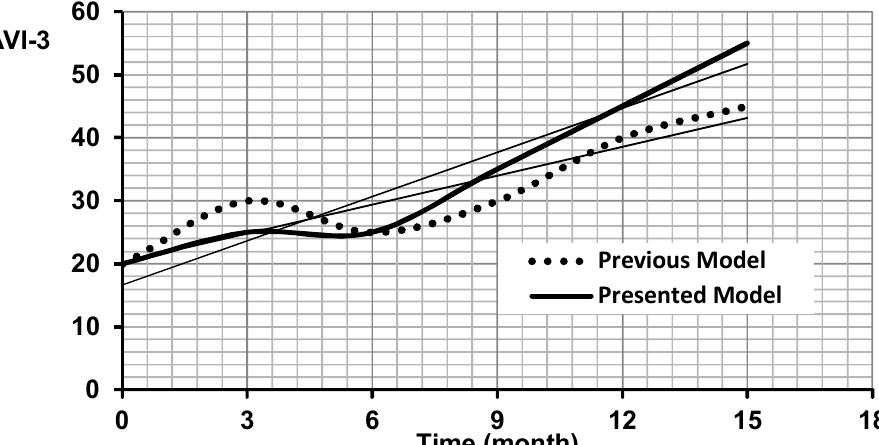
Fig. 6. Comparison between presented and previous KM implementation model for part three of